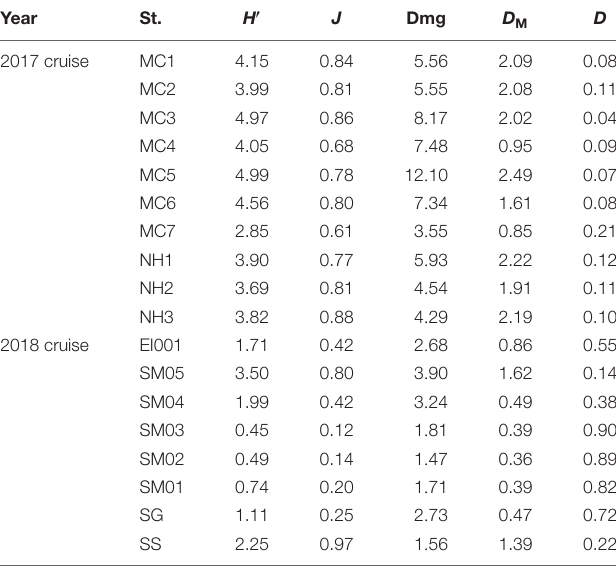
TABLE 3 | Overview of biodiversity indices in phytoplankton community of two cruises. Year St.